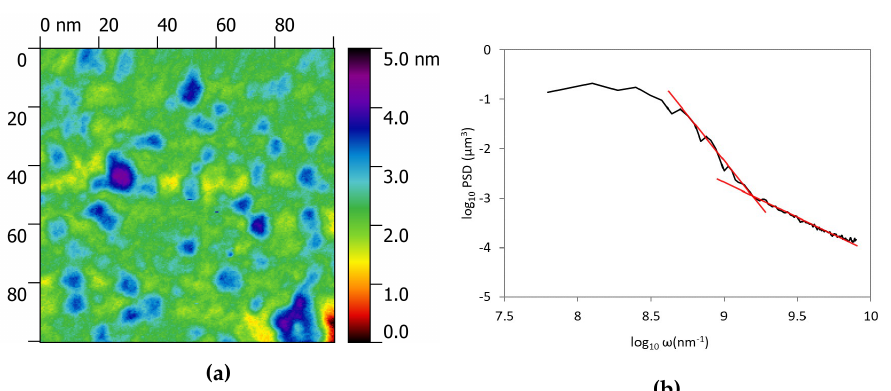
Figure 4. Surface data on a 100 × 100 nm zone. ( a ) is the AFM image and ( b ) is the power spectral density function evaluated in the same area.